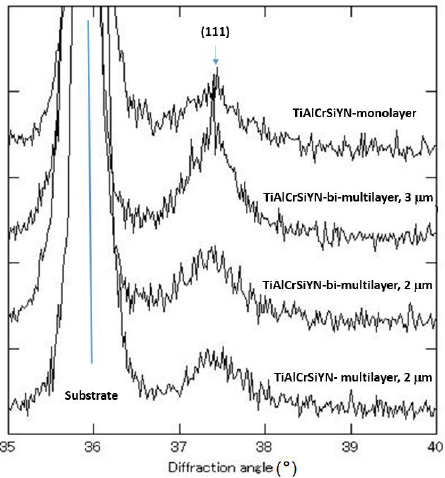
Figure 2. X-ray diffractograms of different TiAlCrSiYN-based coating architectures with different thickness.